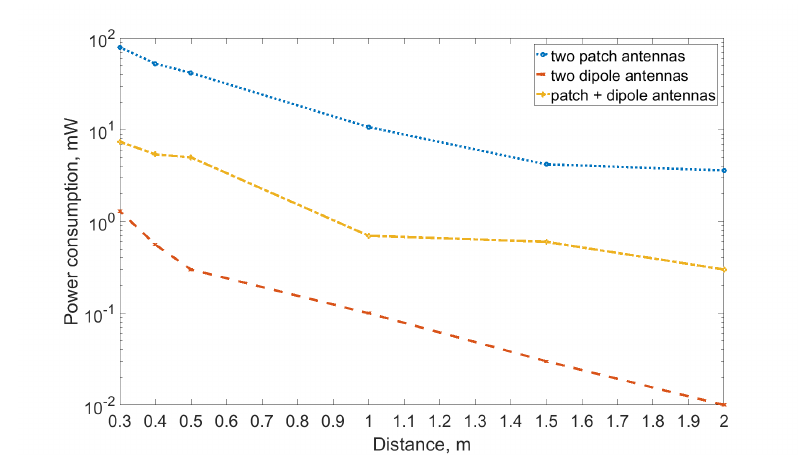
Figure 13. Harvested energy with patch and dipole antennas. Table 5. Harvested energy with patch and dipole type transceiver antennas with 500 mW (27 dBm) transmission power.